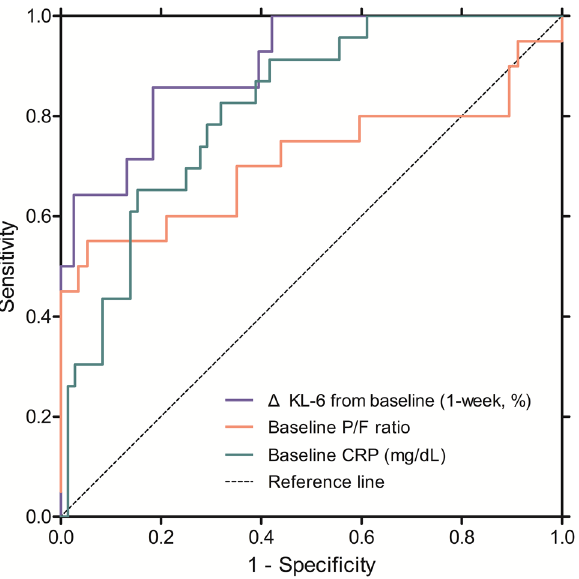
Figure 2. Comparison of the receiver operating characteristic curve of blood markers for predicting in-hospital mortality in patients with AE-ILD. AE-ILD acute exacerbation of interstitial lung disease; ROC curves: blue line, KL-6 relative change from baseline; red line, baseline P/F ratio; green line, baseline CRP. KL-6 Krebs von den Lungen-6, P/F ratio ratio of partial pressure of oxygen to the fraction of inspiratory oxygen, CRP C-reactive protein, AUC area under the curve.